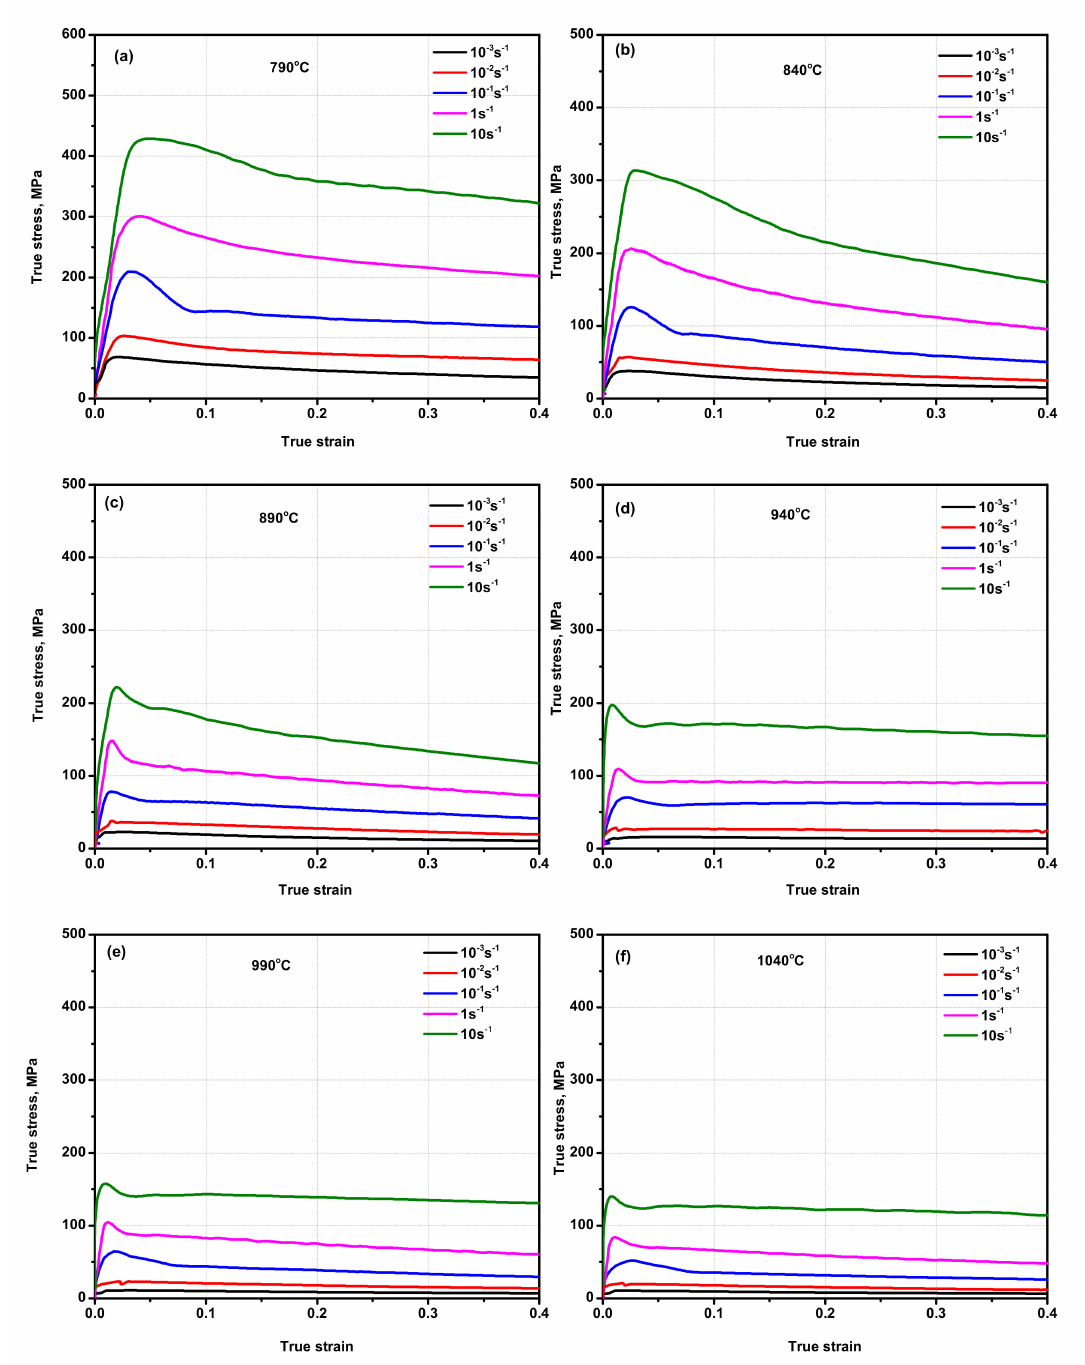
Figure 2. True stress-strain relationships of Ti6Al4V-5Cu alloy during hot compression experiment performed at various strain rates and temperatures, ( a ) 790 ◦ C, ( b ) 840 ◦ C, ( c ) 890 ◦ C, ( d ) 940 ◦ C, ( e ) 990 ◦ C, and ( f ) 1040 ◦